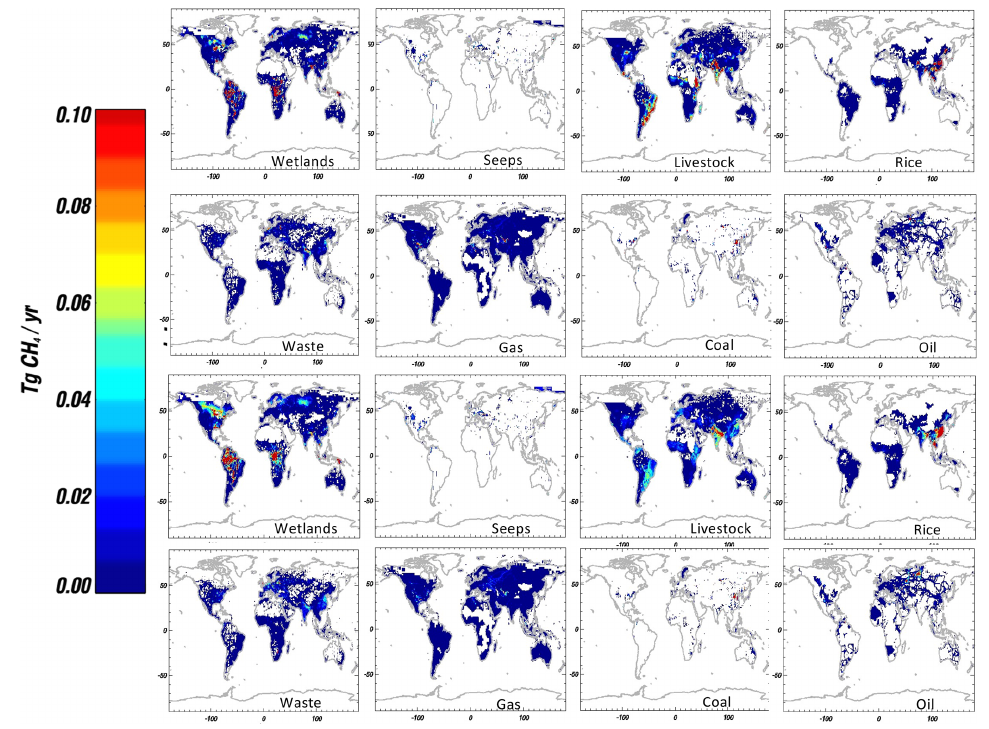
Figure 4. Top: posterior methane emissions. Bottom: posterior emissions uncertainty as calculated by the square root of the diagonal of the posterior covariance